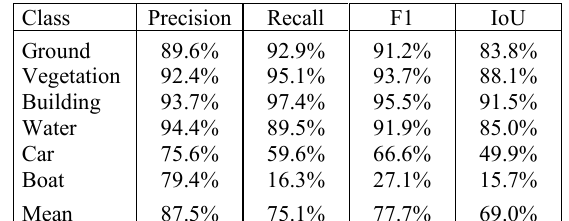
Figure 4 . From top: Reference data from manually annotated oblique image; results of image segmentation with CNN, results from hybrid approach (ground classification from lidar data). Results of the semantic segmentation of oblique images